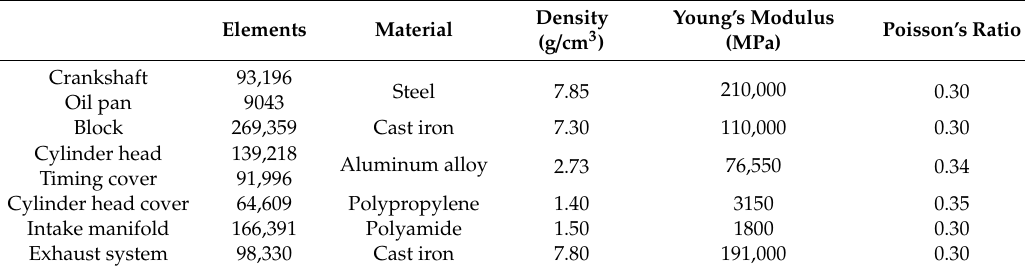
Figure 3. Finite element method (FEM) models of the components. Table 2. Specification of the engine components.